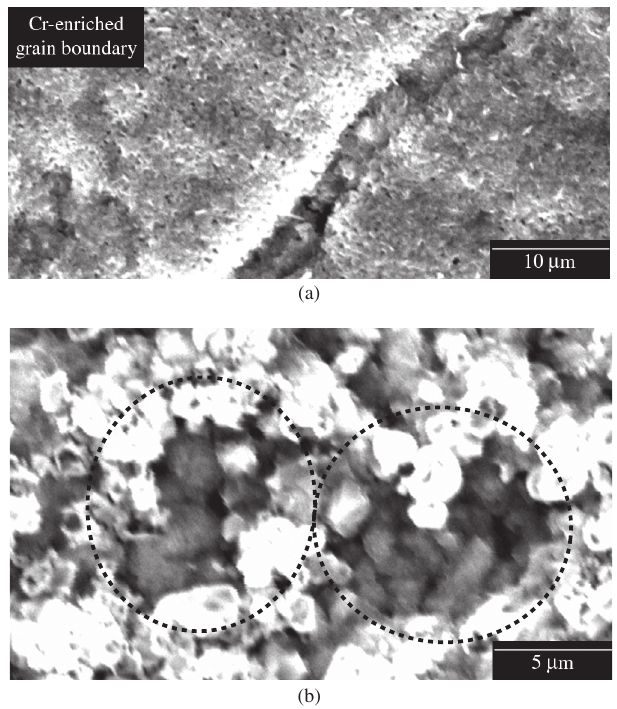
Figure 4. Surface of the scale formed on TP347 at 750 °C after 1.5 hours exposured to air: a) iron oxide formed on top of the grain interior and Cr-en- riched oxide formation along substrate grain boundaries of the coarse-grained specimen (d = 65 µ m); and b) formation of a thick Cr boundaries on the fine-grained specimen (dashed lines).